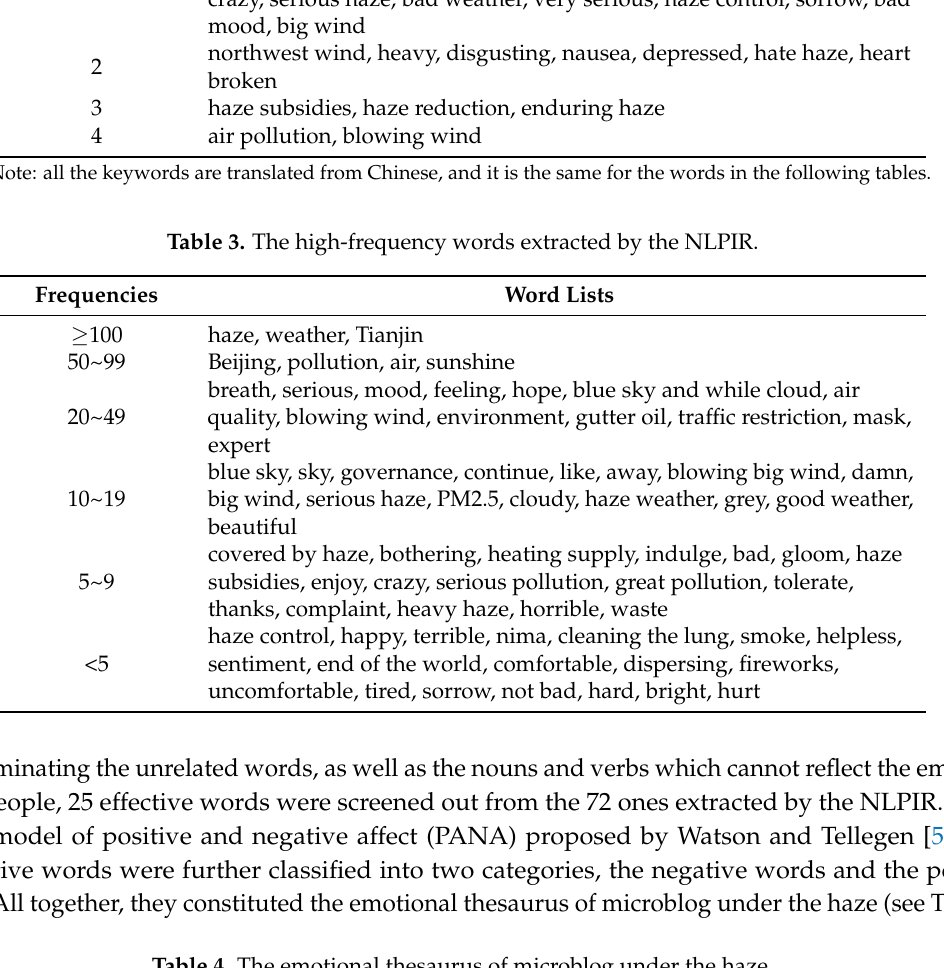
Table 4. The emotional thesaurus of microblog under the